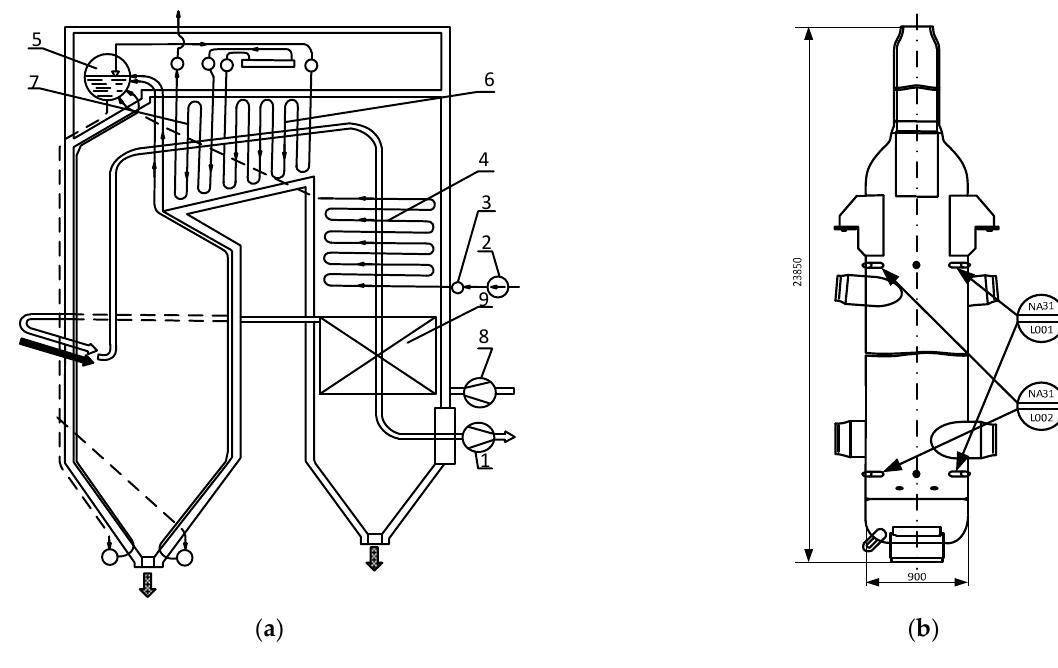
Figure 1. ( a ) Schematic view of a typical boiler: 1—exhaust fan, 2—feedwater pumps, 3—main feedwater valve, 4—economizer, 5—steam separator (drum), 6—primary preheater, 7—secondary preheater, 8—air supply fan, 9—air preheater; ( b ) schematic of a steam drum.